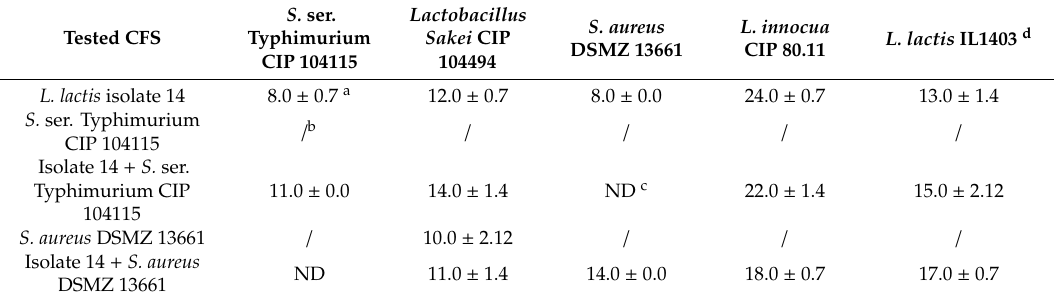
Table 8. Antimicrobial activities of CFSs collected from the culture of L. lactis subsp. lactis -isolate 14 cultivated with and without S. ser. Typhimurium CIP 104,115 or S. aureus DSMZ 13661. Plates were examined for clear inhibition halo (mm), evaluated by the CFS agar well di ff usion assay. Largest inhibition halos are recorded below. CFSs were collected after 16 h of growth for S. ser. Typhimurium CIP 104,115 assays and after 32 h of growth for S. aureus DSMZ 13,661